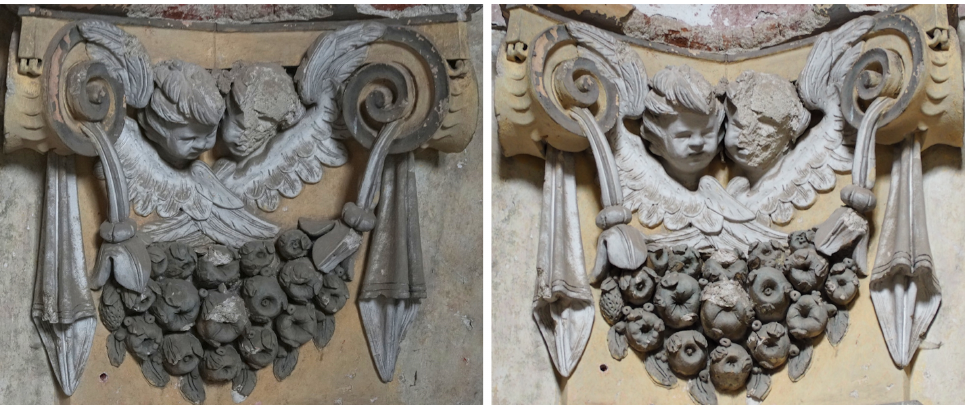
Figure 6. Comparison of the image taken by the onboard camera ( left ) and the image taken by the handheld camera from the ground ( right ). Although an object is located only 12 m above the ground, the difference in captured surfaces between the image captured from the same height and the image captured from below is